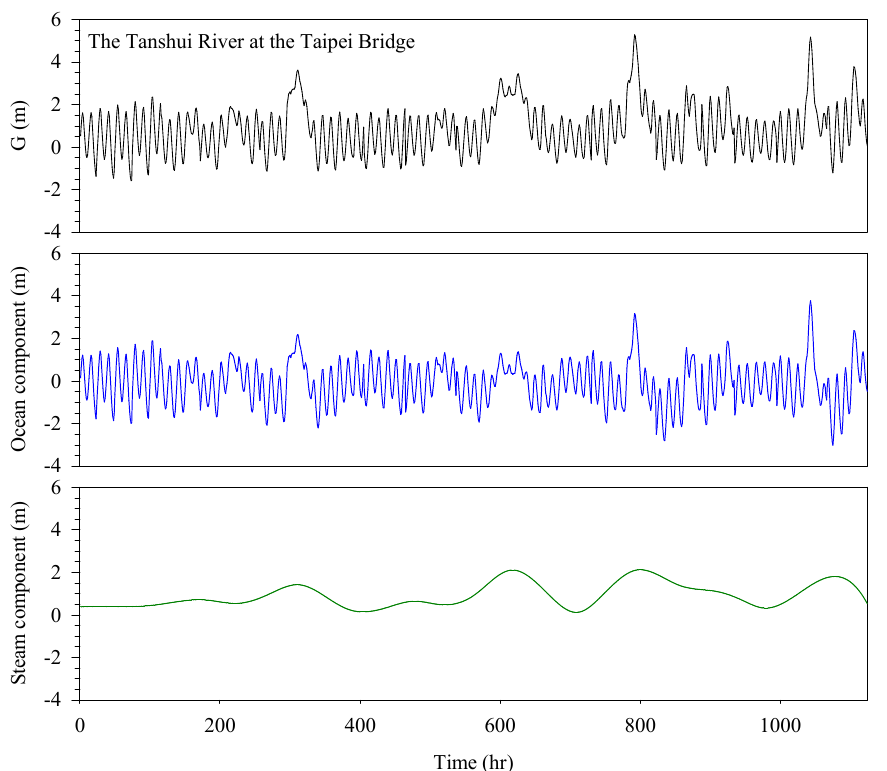
Figure 6. Water level, ocean component, and stream component hydrographs of the Tanshui River at the Taipei Bridge.